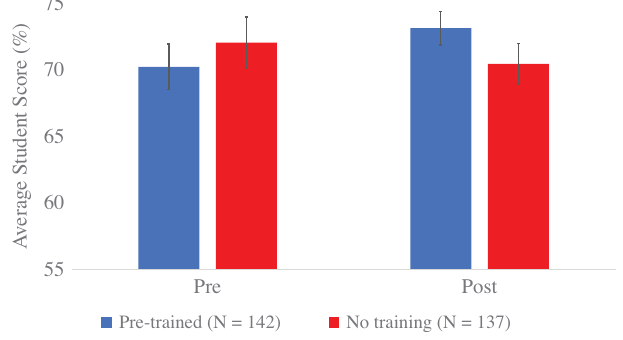
FIG. 4. Averagescoresonpretestandpost-testsforthegroupthat received preliminary training, and the group that did not. Here, and in all subsequent figures, error bars represent standard error.